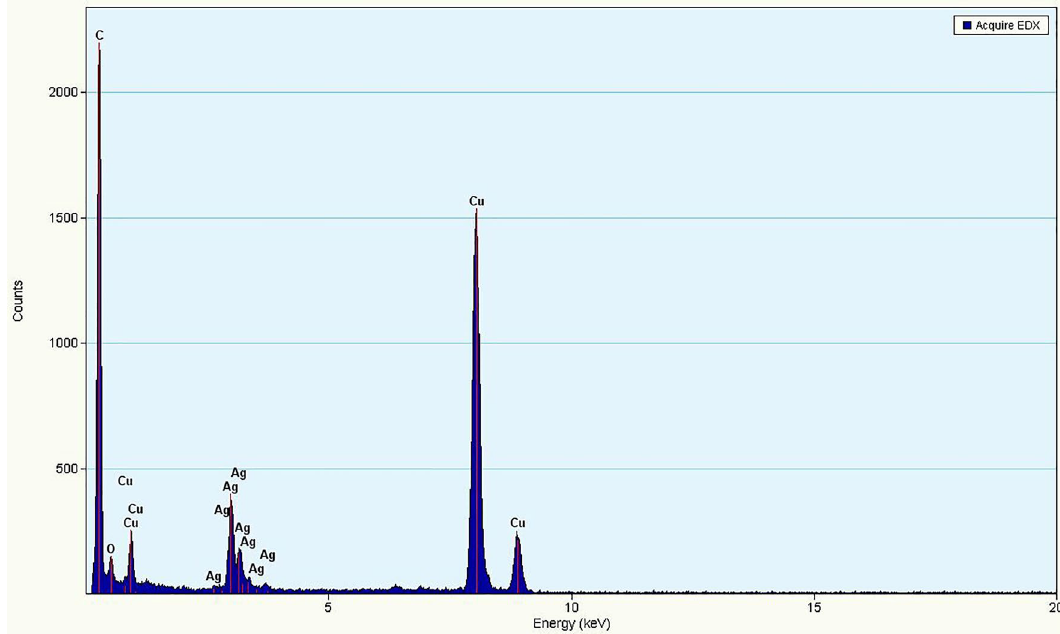
Figure 4. EDX spectra of phytosynthesized AgNPs.